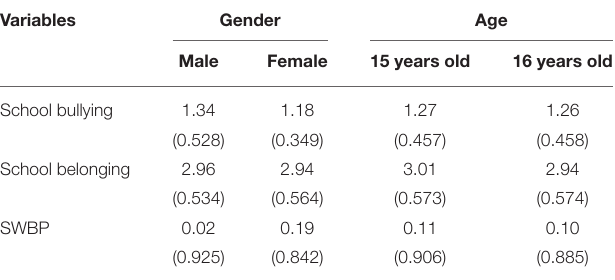
TABLE 1 | Differences in gender and age of related variables.